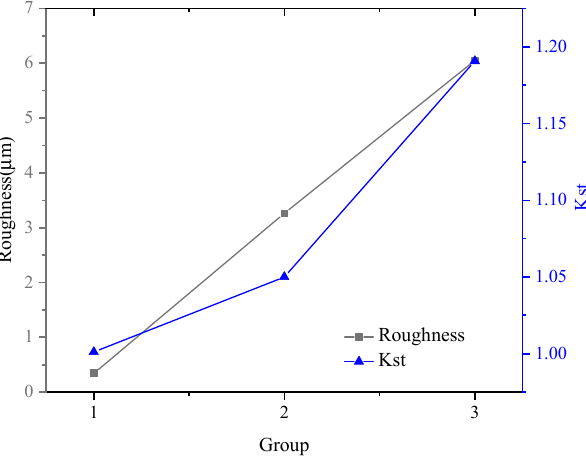
Figure 4. Variation of roughness R a and K st with turning parameters.